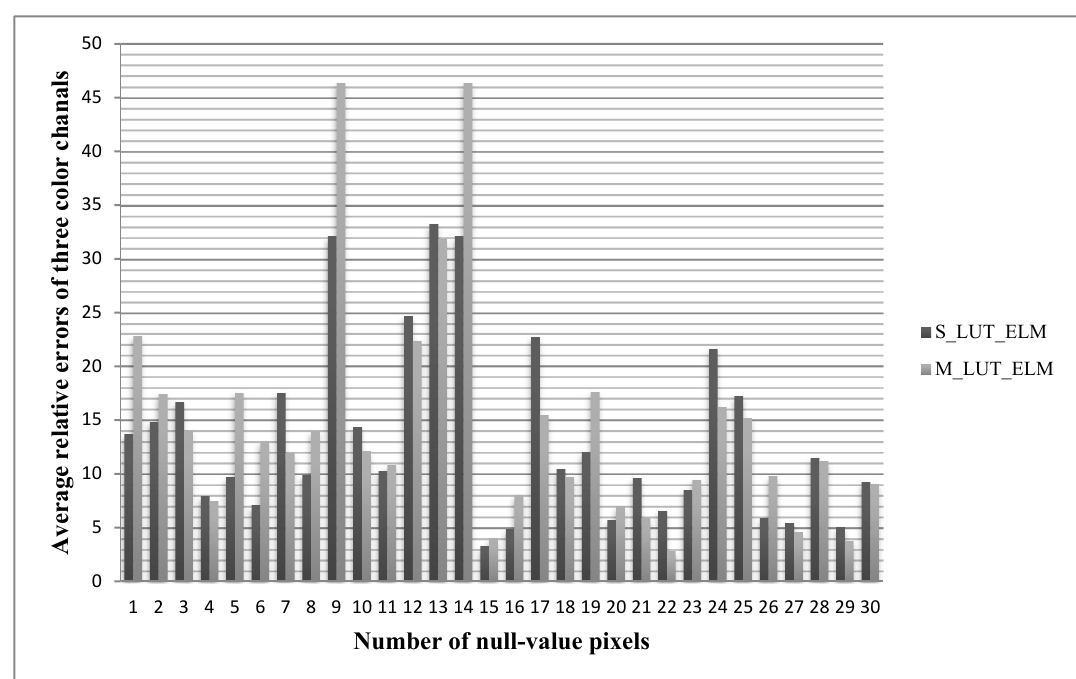
Figure 5. Comparison of the relative error of the estimated values using two ELM methods.